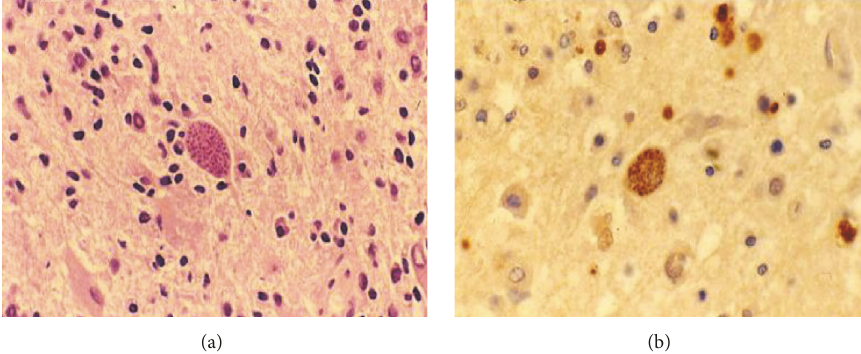
Figure 2: (a) Toxoplasma cyst demonstrated on H and E stain × 40. (b) Toxoplasma cyst confirmed on immunocytochemistry ×